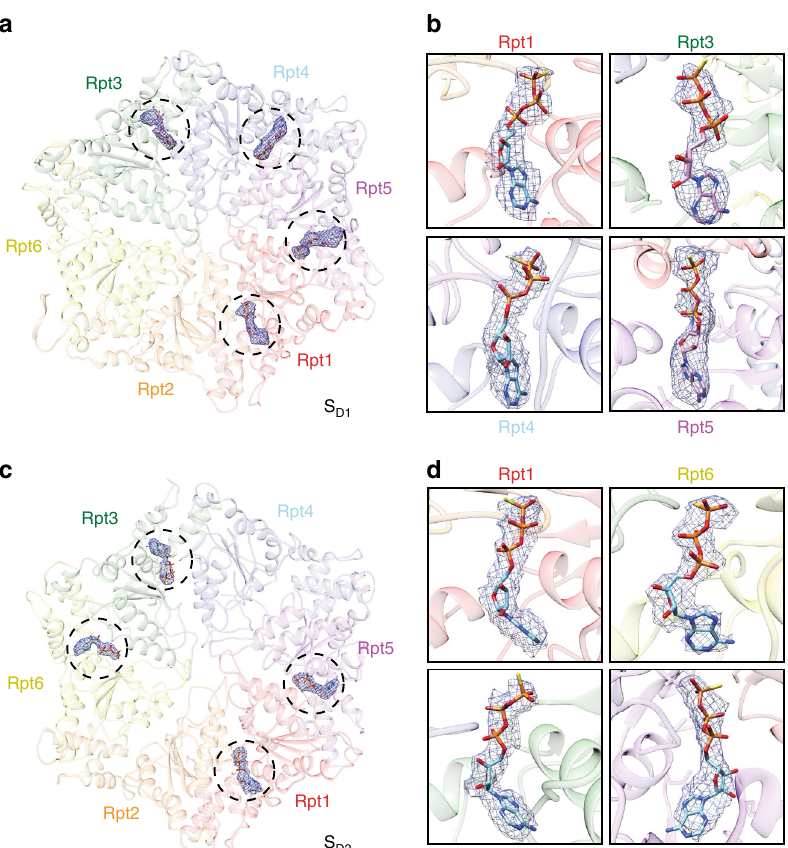
Fig. 5 Cryo-EM densities of the nucleotides in the S D1 and S D2 states of the ATP- γ -S-bound RP – CP subcomplex. a , c Overview of the nucleotide-binding sites in the AAA-ATPase heterohexamer of the ATP- γ -S-bound human 26S proteasome in the S D1 ( a ) and S D2 ( c ) states. Bound nucleotides are shown in a stick representation superimposed over their respective cryo-EM densities in a blue mesh representation. b , d Close-up views of nucleotide conformations in the nucleotide-binding sites in the S D1 ( b ) and S D2 ( d ) states. ATP- γ -S was modeled into the nucleotide densities of four Rpt subunits in each